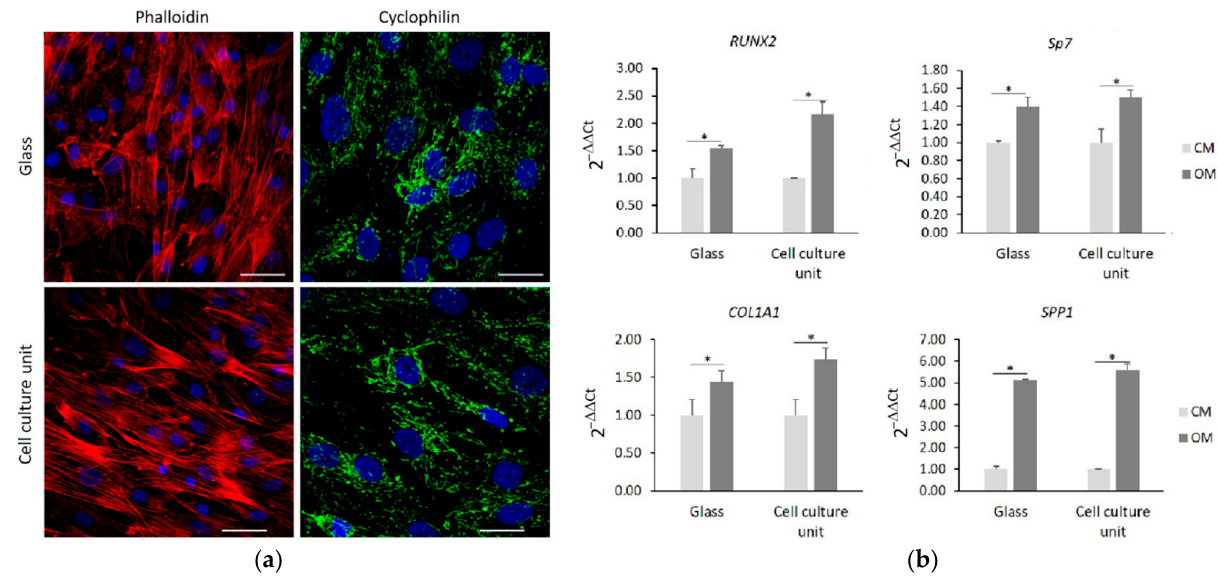
Figure 5. hMSC were cultured on cell culture unit and on glass coverslips. ( a ) After 72 h, cells were observed by confocal microscopy after phalloidin, cyclophilin F, and DAPI staining. Scale bar: 50 μ m. ( b ) Confluent hMSC were cultured for 24 h in OM. Real-Time PCR was performed on RNA extracted from hMSC using primers designed on RUNX2 , Sp7 , COL1A1 , and SPP1 sequence (* p ≤ 0.05).